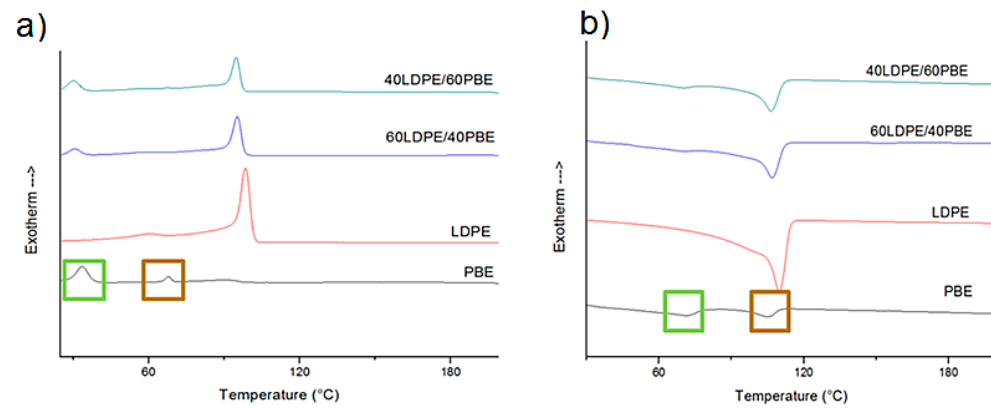
Figure 3. Di ff erential scanning calorimetry (DSC) curves of PBE, LDPE and PBE / LDPE blends; ( a ) represents the crystallization curves and ( b ) the melting curves.